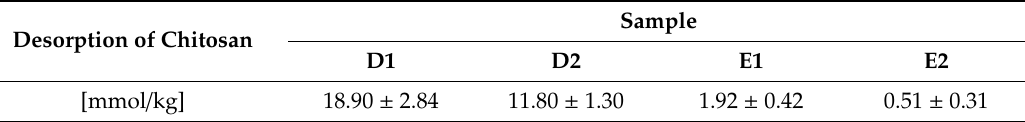
Table 9. Desorption of chitosan amino group per gram of